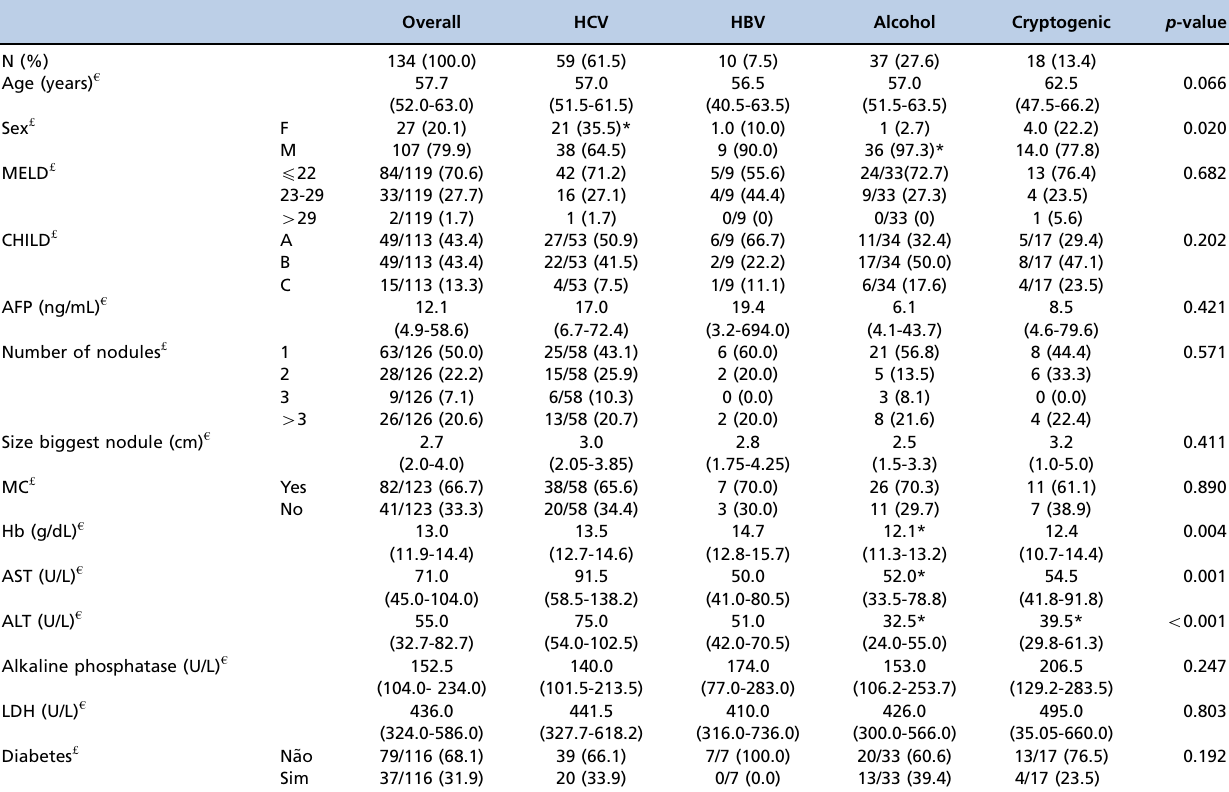
Table 1 - Demographic and laboratorial characteristics according to CLD etiology. Overall HCV HBV Alcohol Cryptogenic p -value